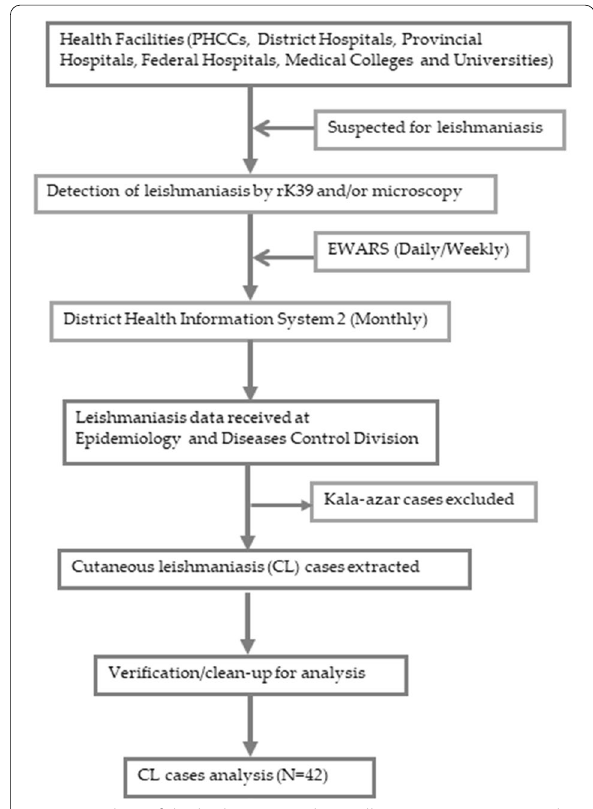
Fig. 1 Outline of the leishmaniasis data collection process in Nepal. PHCC Primary Health Care Center, CL cutaneous leishmaniasis, EWARS Early Warning and Reporting System